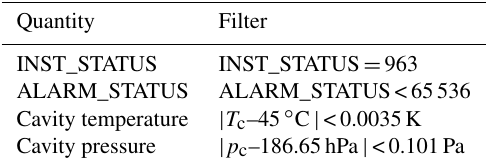
Table 2. Diagnostic values indicating normal status of the CRDS